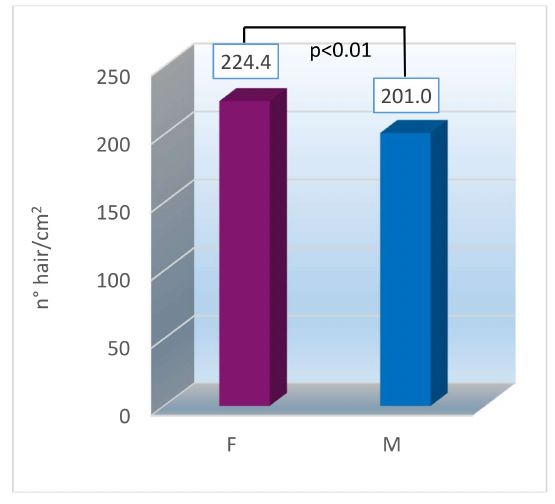
Figure 4. Mean basal values of hair density as a function of gender.